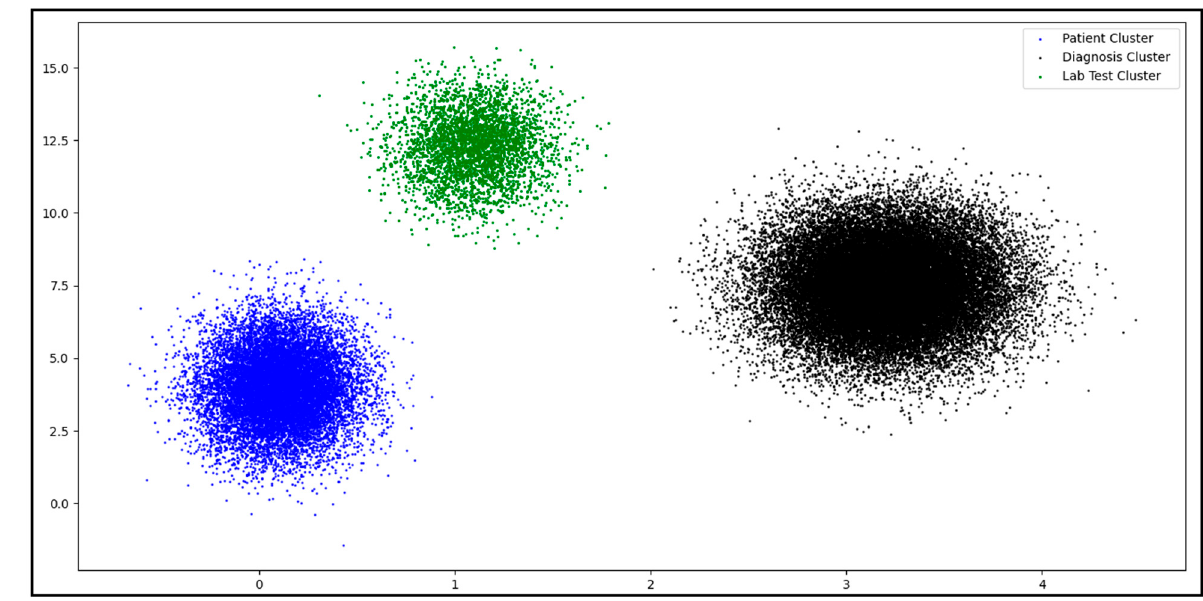
Figure 4. HL7 v2 dataset clustering result.